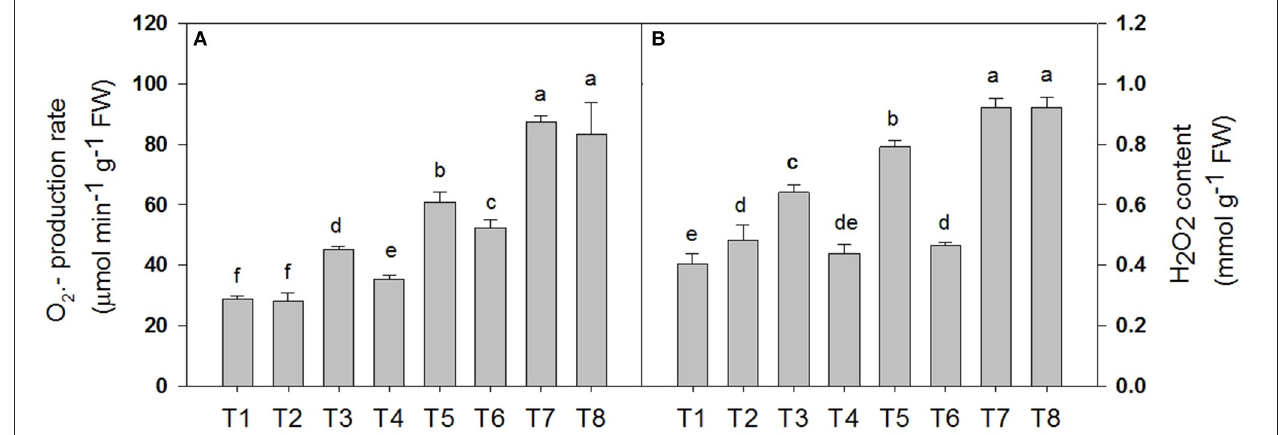
FIGURE 4 | Effects of SA on the superoxide anion (O . − 2 ) production rate (A) and the peroxide (H 2 O 2 ) content (B) of D. superbus grown under salt stress (means ± SD ). Different letters indicate significant differences ( P < 0.05) according to an LSD-test; the same letter indicates no significant differences between the treatments, n =